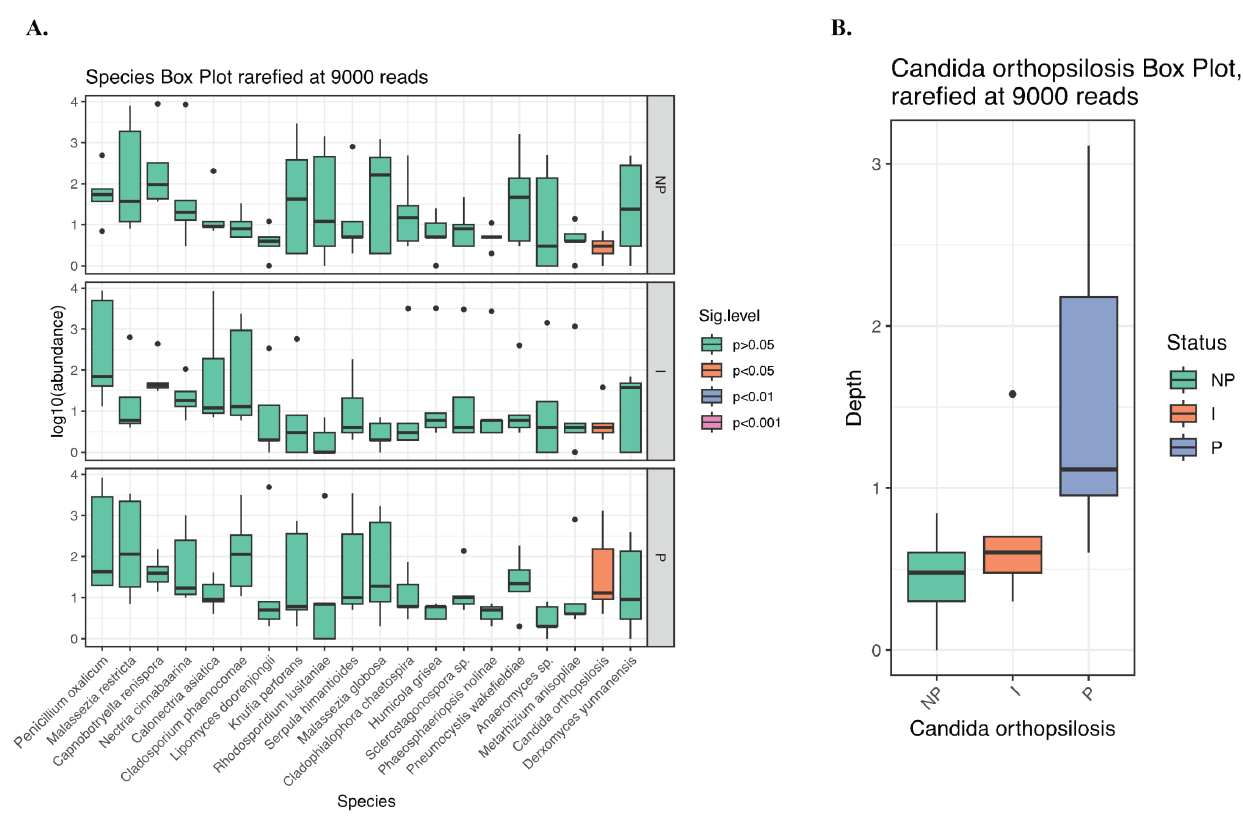
Figure 5. Boxplots representing relative abundance analysis of the fungal taxa identified in nasal samples of individual from the different S. aureus carrier groups. ( A ) Differential abundance at the species level. ( B ) Differential abundance for the species Candida orthopsilosis showed a significant difference in abundance between the persistent and non-carrier groups ( p<0.05, Kruskal-Wallis test ). Taxa with minimum median abundance of 1% were used for the comparison. NP: non-carrier, I: Intermittent, P: persistent.